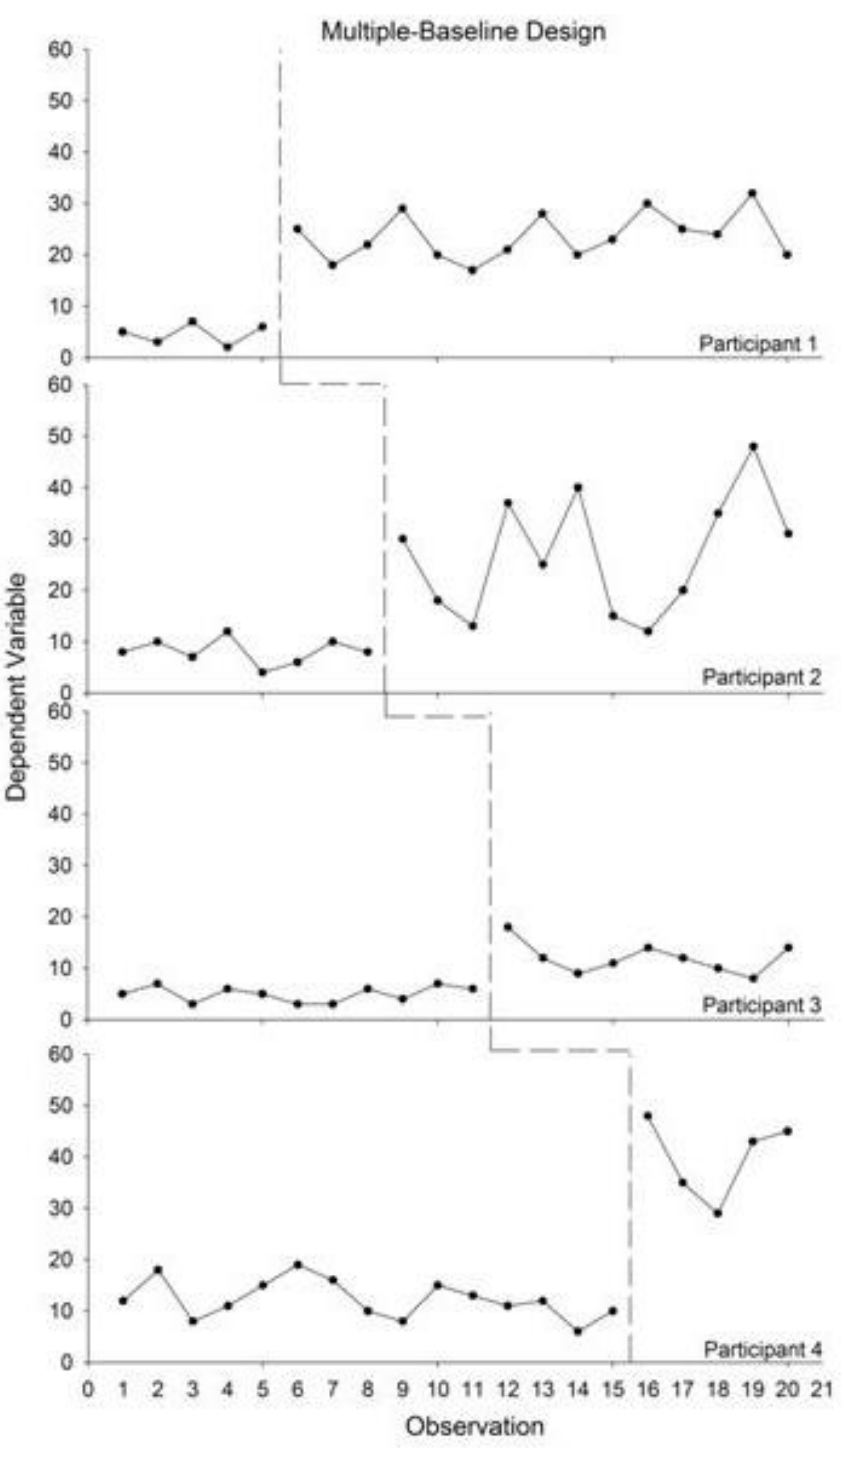
Figure 2. Example of a multiple baseline design showing experimental control and replications between subjects (each row represents a different participant, each of whom experienced a baseline and treatment; the baseline durations differed across